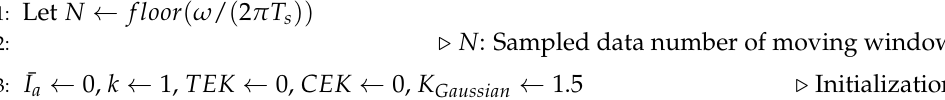
Algorithm 1 The pseudo-code describing the proposed fault detection method is